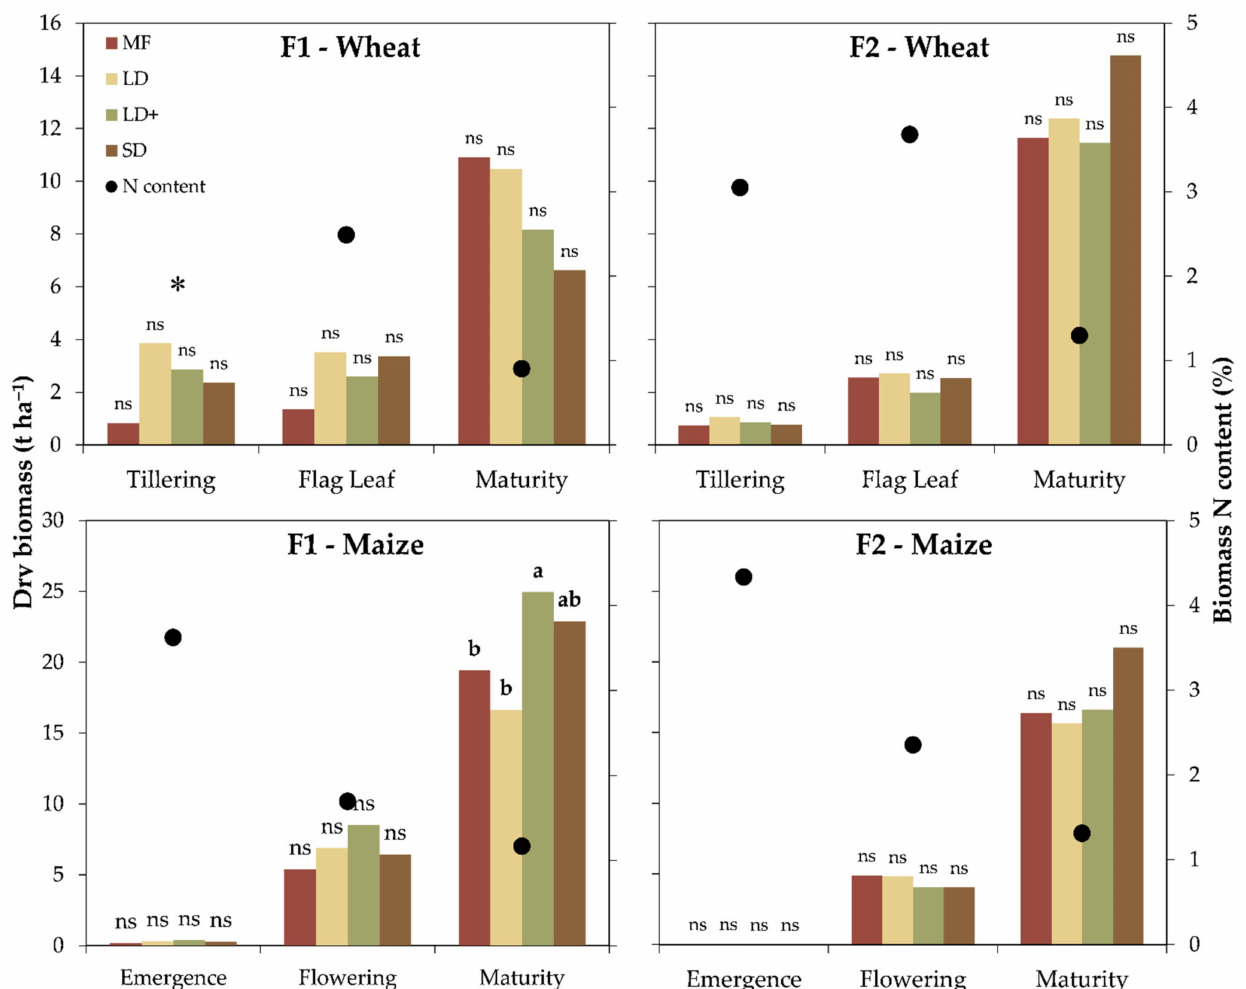
Figure 2. Crop dry biomass (bars) and biomass N content (points) by treatment (MF: mineral fertilizer, LD: liquid digestate, LD+: liquid digestate with a nitrification inhibitor and SD: solid digestate) for both farms (F1 and F2) and crops (winter wheat and maize); * missing data. Different letters identified significant differences among treatments according to the Tukey test at p ≤ 0.05. ns = not